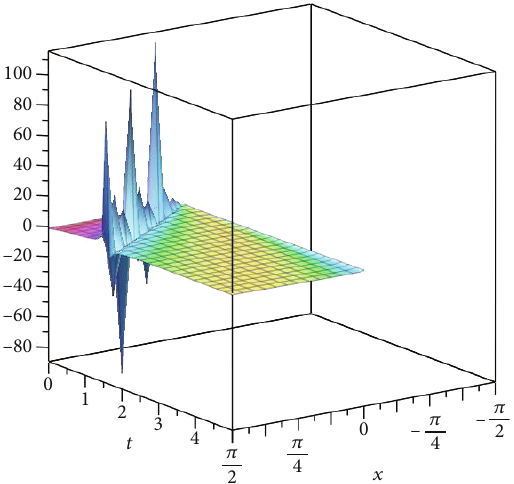
ð x , y , t Þ given by 6